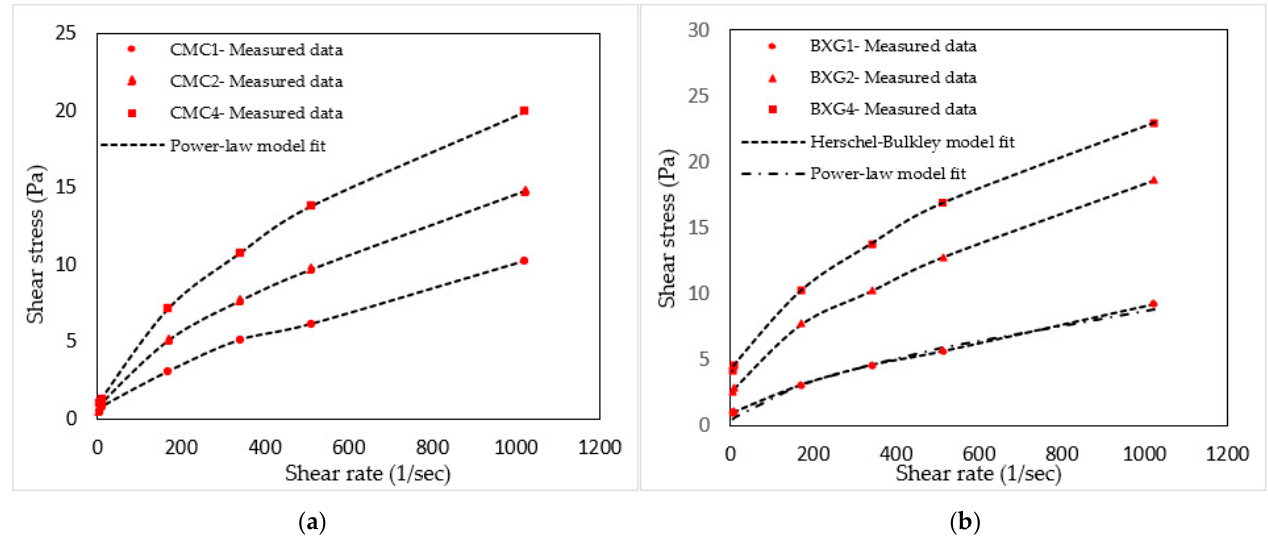
Figure 3. Shear stress vs. shear rate curves for non-Newtonian models. ( a ) Rheological curves of power-law model fi t. ( b ) Rheological curves of Herschel–Bulkley model fi t.